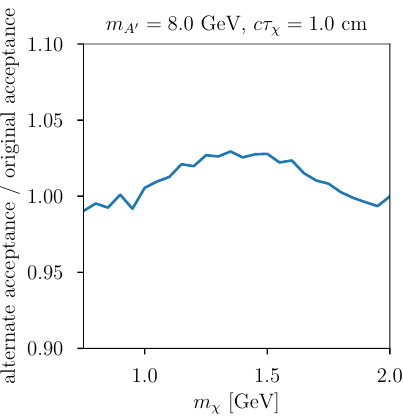
Figure 14 . Ratio of acceptances of a N dv ≥ 1 , N tr ≥ 3 search with a m A 0 = 8 GeV , cτ χ = 1 cm signal for the original χ → π + π − π + e − decay model compared to the alternate model where we have adjusted some of the intermediate resonance masses. This ratio is within 5% of unity over the mass range for which we use the exclusive meson decay